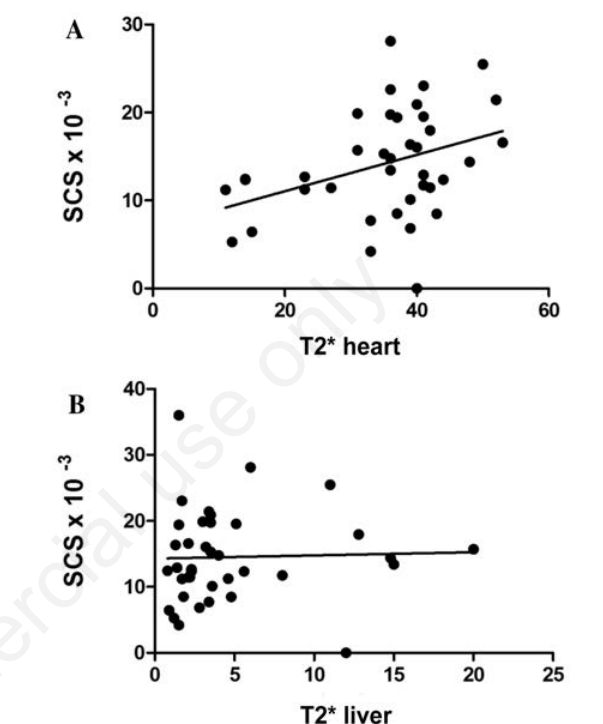
Figure 4. Correlation between skin carotenoid score (SCS) and magnetic resonance (MR) T2* values of the myocardium (A) or liver (B) in b -thalassemia patients. SCS values are the mean of two measurements during the year of the study. Liver and hearth